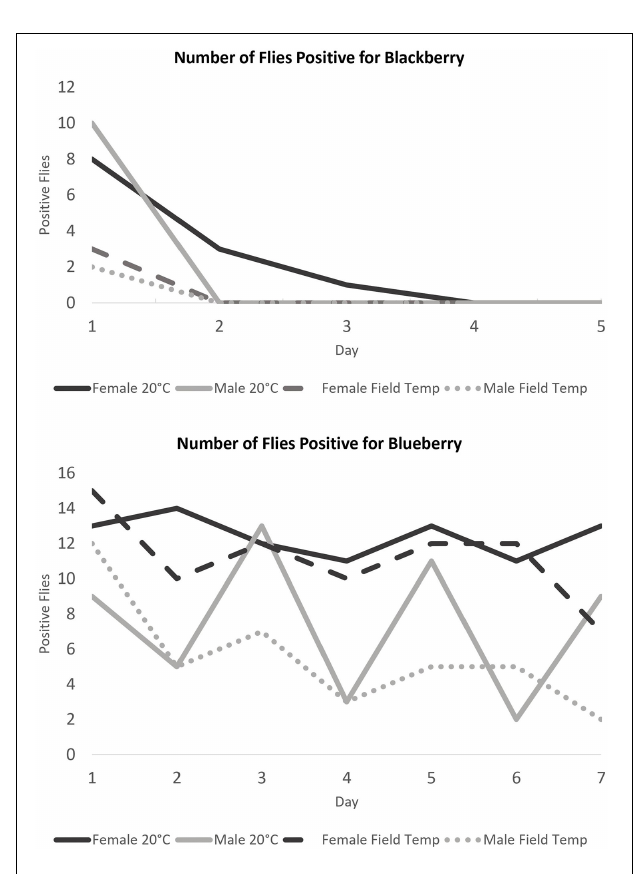
FIGURE 2 | Number of flies positive for each type of berry DNA out of 15 total flies tested per treatment. The Y-axis represents the total positive flies and the X-axis represents days after the initial berry